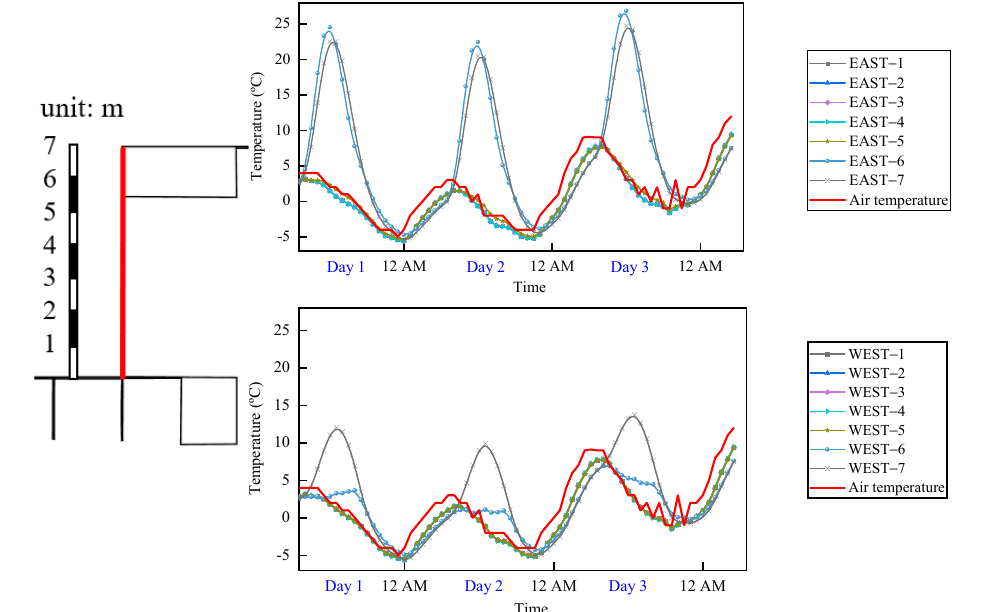
Figure 17. Temperature changes of several points on eastern and western inner surfaces of the empty aqueduct in winter (WEST stands for the western inner surface, and EAST represents the eastern inner surface. The number after the hyphen is its vertical coordinate).